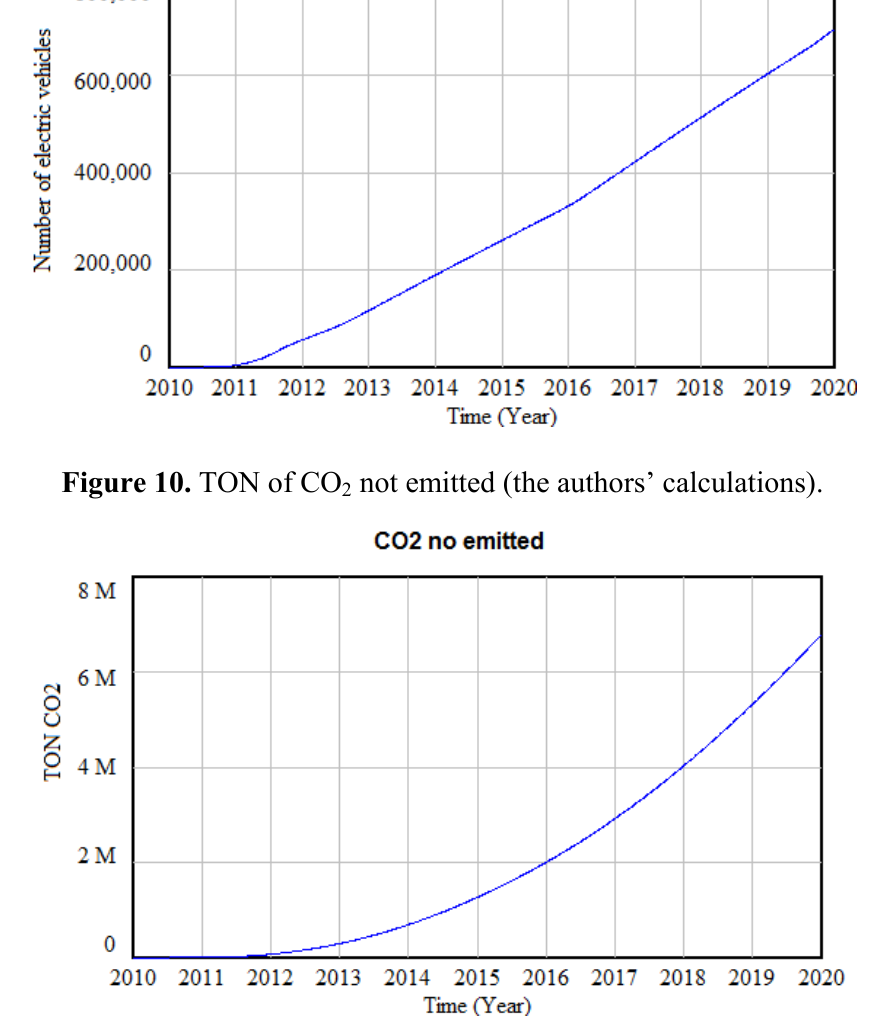
Figure 9. Electric vehicles on Spanish roads (the authors’ calculations).